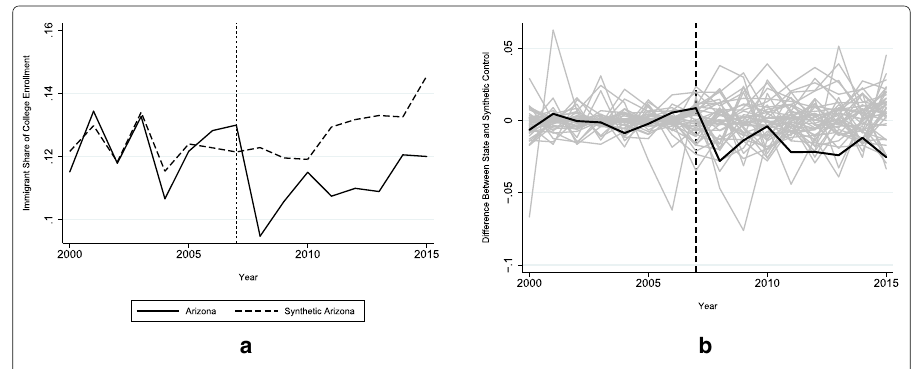
Fig. 6 LAWA and share of immigrants in college. a Share of immigrants. b Permutation